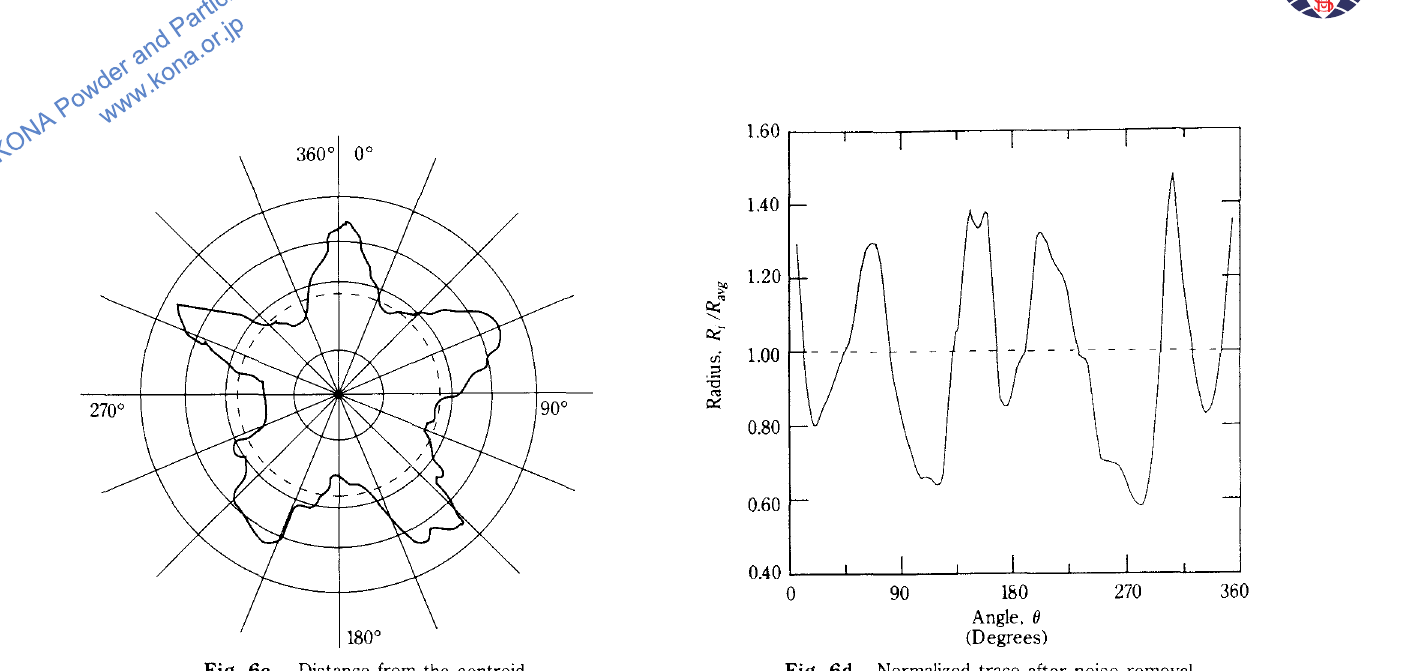
Fig. 6a. Distance from the centroid.